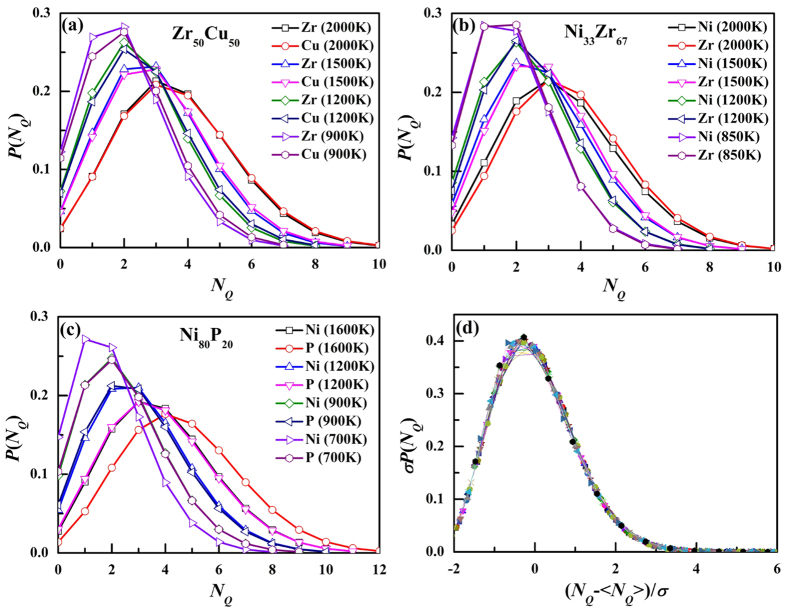
The temperature dependence of the distributions of NQ in (a) Zr50Cu50, (b)Ni33Zr67 and (c) Ni80P20, (d) the distributions of NQ, shifted by the average value <NQ> and scaled by the standard deviation σ for those in (a–c).